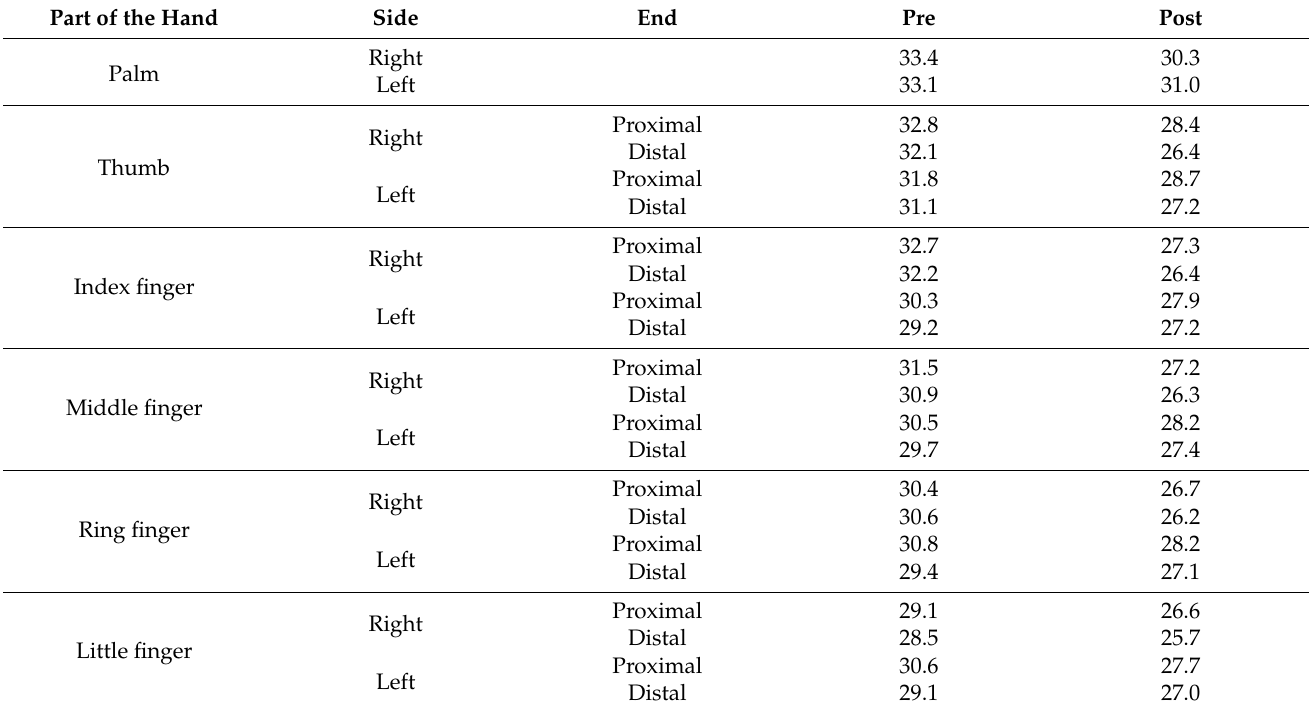
Table 6. Temperature values of the hands and fingers of the